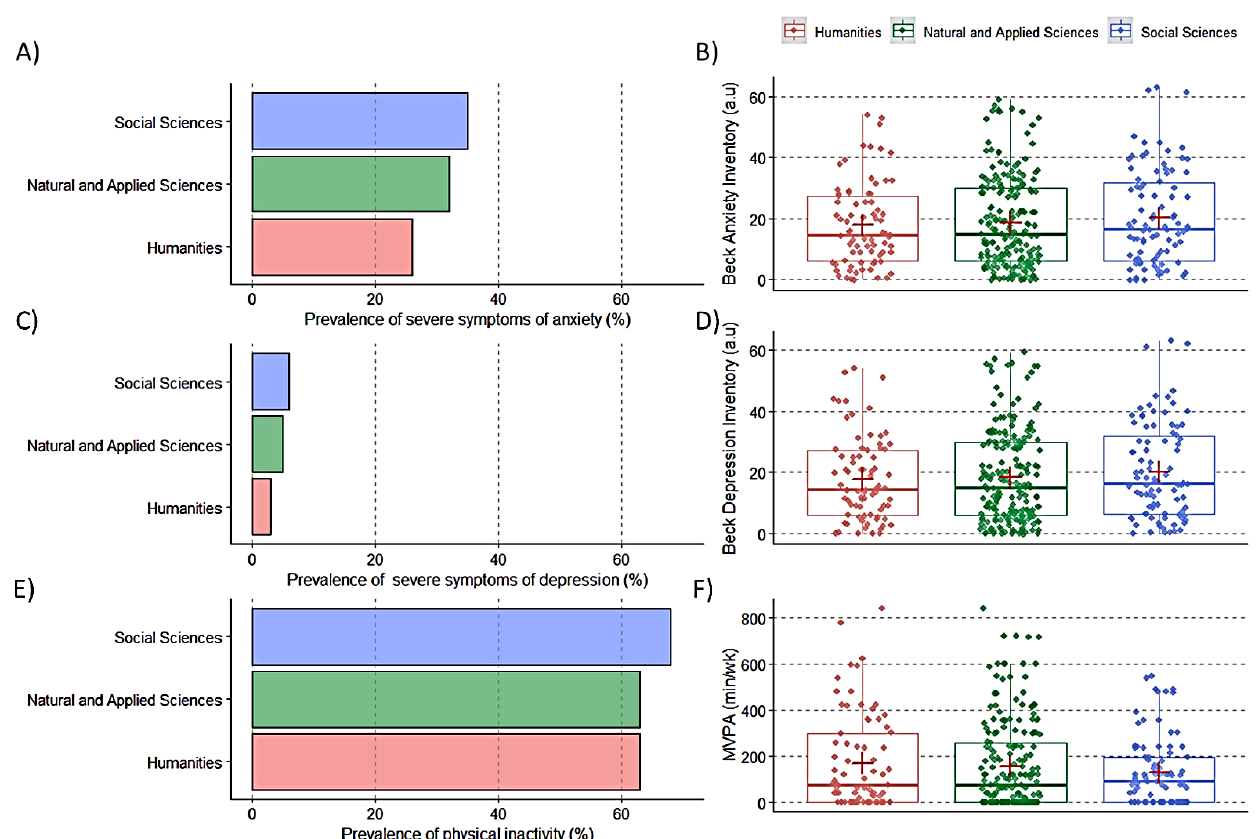
Figure 3. Scores of anxiety, depression, and physical inactivity according to academic areas. Panel ( A ): Prevalence of severe symptoms of anxiety (Score > 25); Panel ( B ): Scores obtained in Beck anxiety inventory; Panel ( C ): Prevalence of severe symptoms of depression; Panel ( D ): Scores obtained in Beck depression inventory (Score > 35); Panel ( E ): Prevalence of physical inactivity (<150 min/week of moderate-to-vigorous activity); Panel ( F ): Time spent in moderate to vigorous physical activity (MVPA).